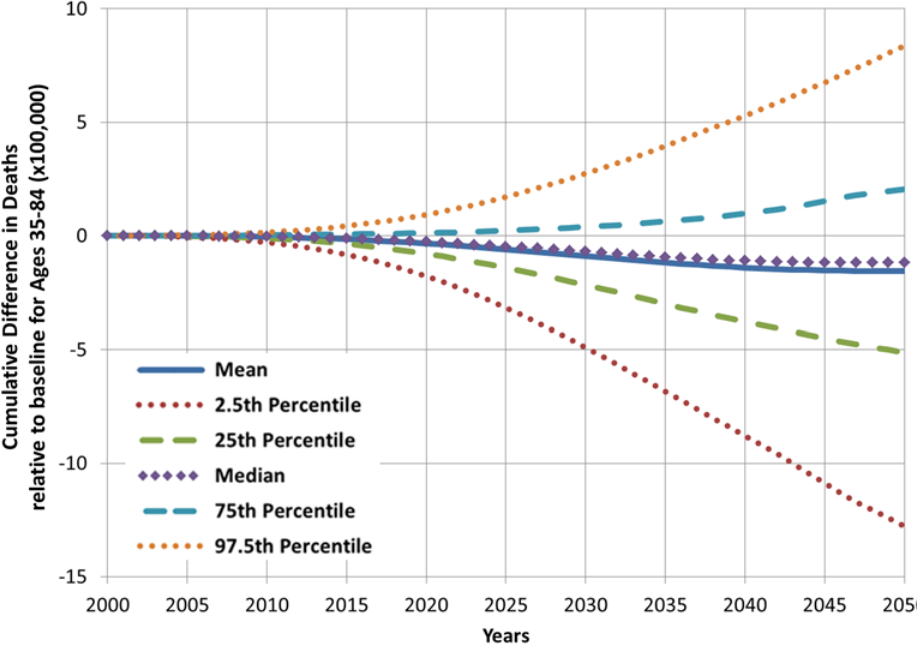
Fig 11. Projected cumulative difference in deaths for the new product scenario compared with the status quo scenario, from multivariate uncertainty analysis, 2000 – 2050.